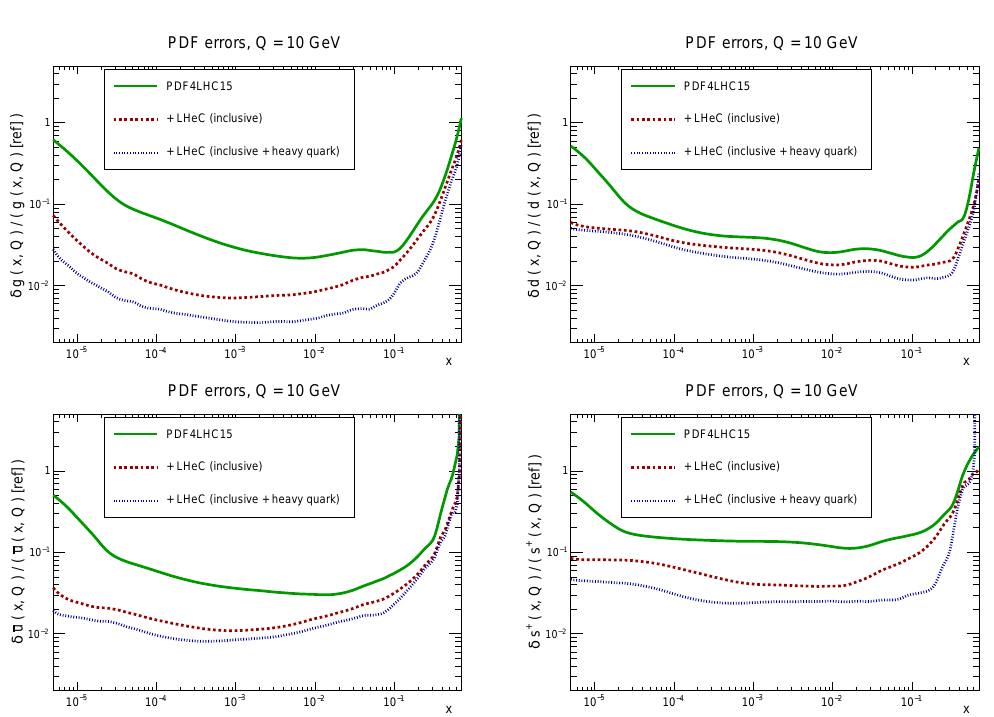
Figure 4.1: Impact of LHeC on the 1– σ relative PDF uncertainties of the gluon, down quark, anti–up quark and strangeness distributions, with respect to the PDF4LHC15 baseline set. In this comparison, shown at Q = 10 GeV, we indicate the results of both profiling with the inclusive LHeC measurements alone and also with the semi- inclusive heavy quark structure